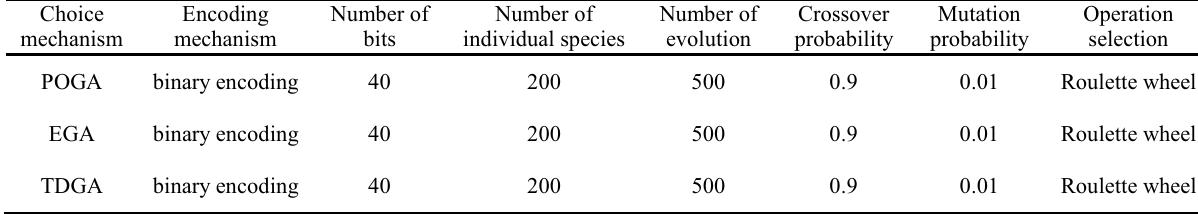
Table2. List of specific